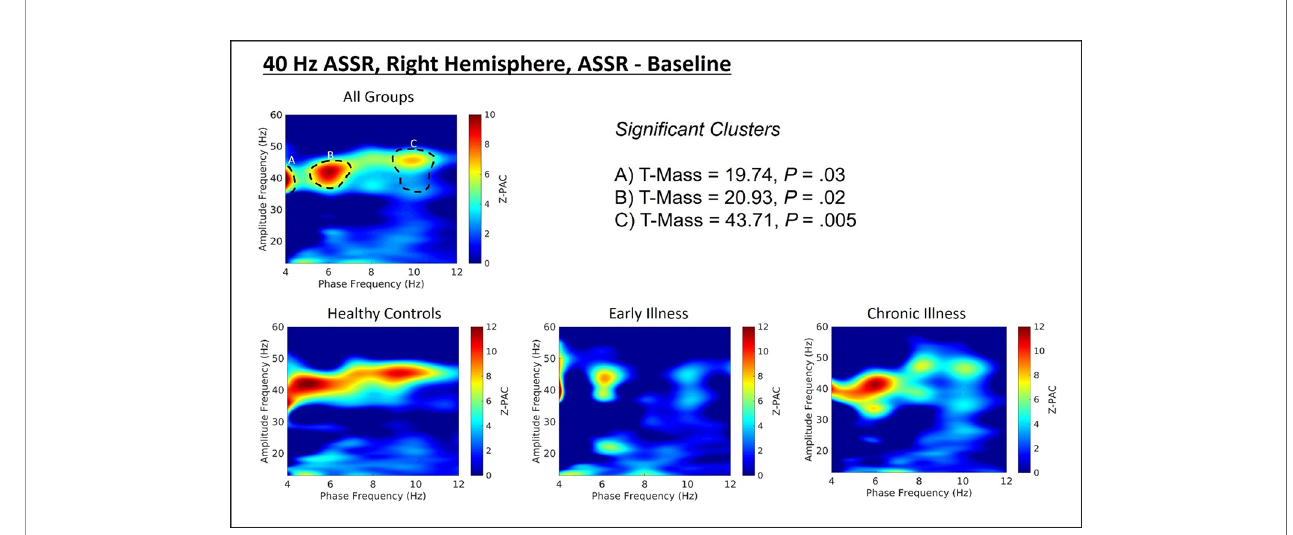
FIGURE 2 | (Top) Right hemisphere Phase-amplitude coupling T-maps demonstrating differences between stimulation and baseline periods of the trial, with subjects pooled across groups. (Bottom) Right hemisphere PAC compared between